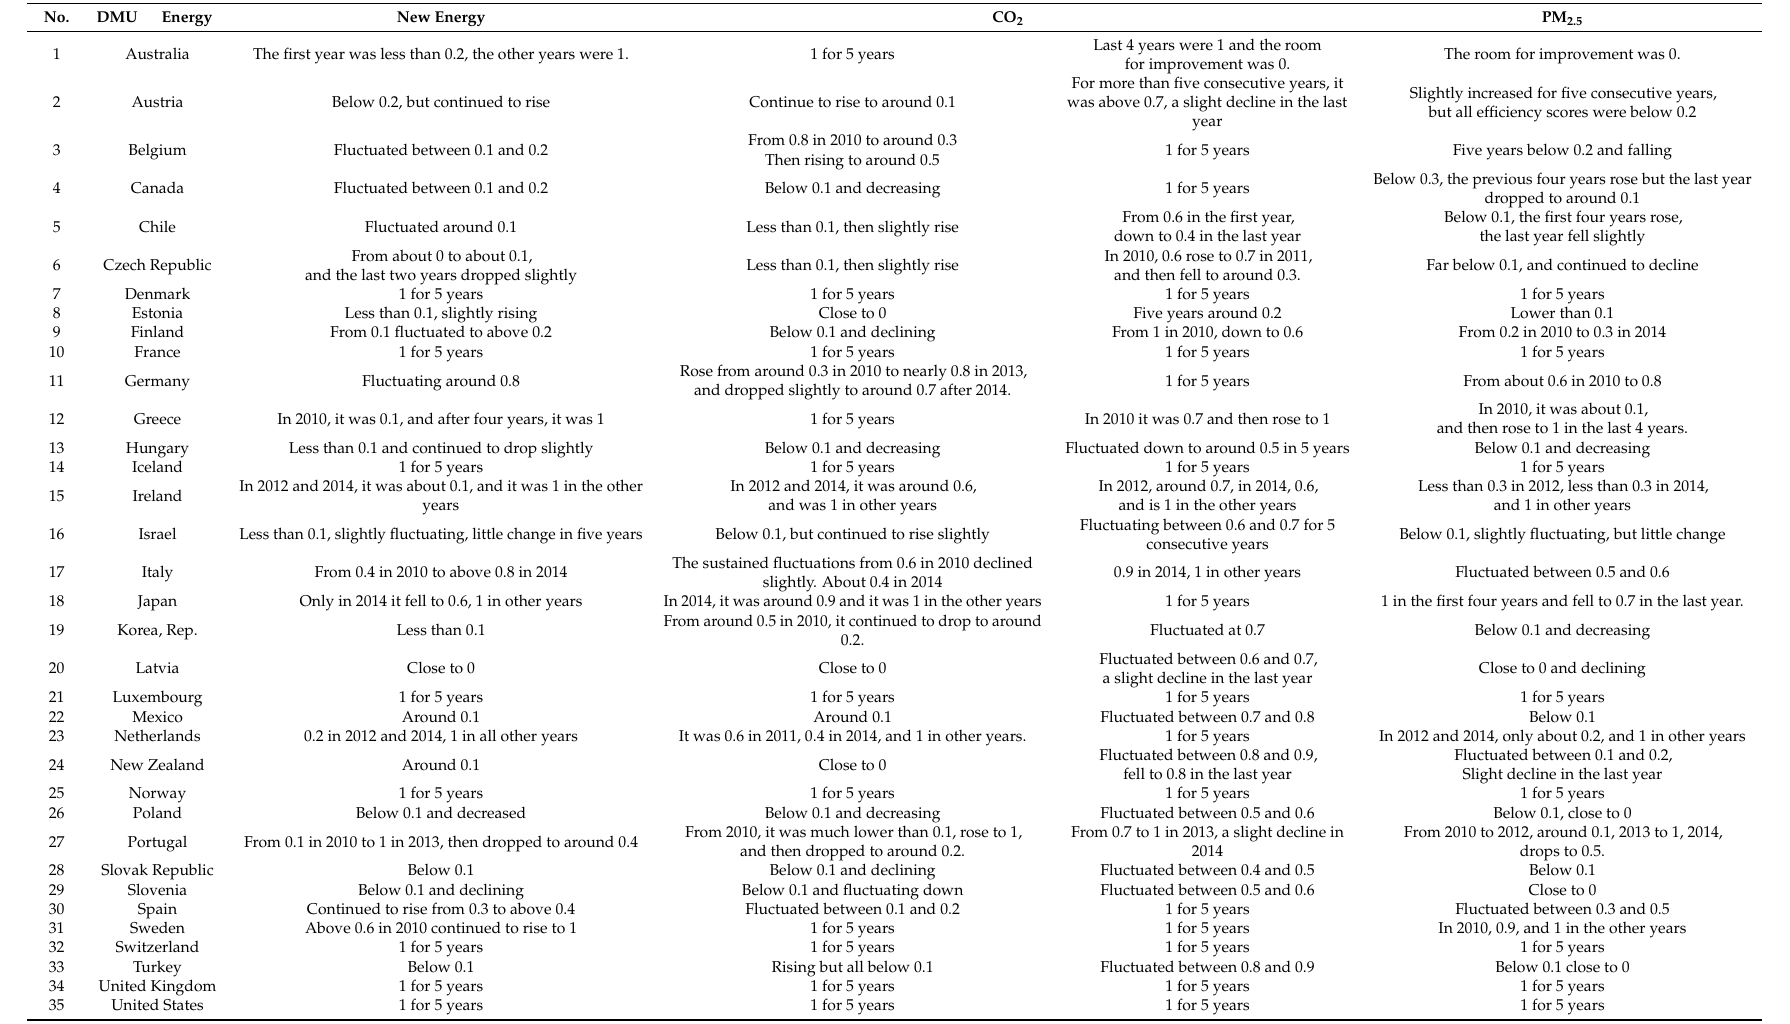
Table 9. Energy, New Energy, CO 2 and PM 2.5 efficiency